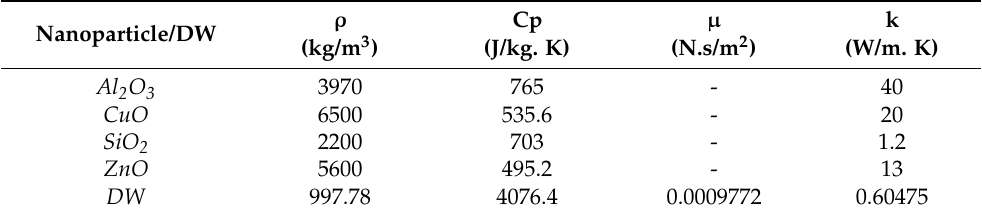
Table 1. Values of thermophysical properties for DW and metallic oxides [33,35,36].